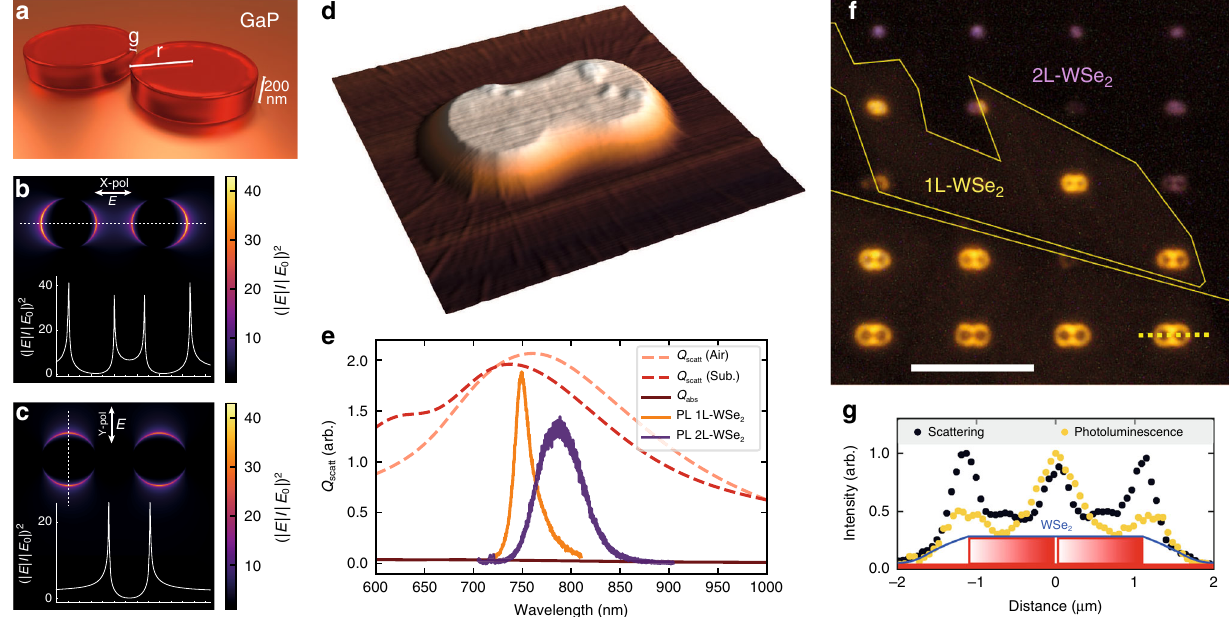
Fig. 1 Coupling of an atomically thin semiconductor to a dielectric nano-antenna. a Schematic view of a GaP dimer nano-antenna with a height h = 200nm, gap jÞ 2 of light at 685nm scattered by a GaP dimer with r = 50nm, h = 200nm, and g = 65nm. width g , and pillar radius r . b , c Calculated relative intensity ðj E j = j E 0 E ( E 0 ) is the electric fi eld amplitude of the light scattered by (normally incident on) the dimer. The polarisation of the incident light is shown with arrows. ðj E j = j E jÞ 2 is calculated at the height of 200nm corresponding to the top surface of the pillars. The inset shows the variation of ðj E j = j E jÞ 2 along the horizontal 0 0 and vertical dotted lines. d Atomic force microscopic (AFM) image of a GaP nano-antenna ( r ¼ 500 nm) covered with a monolayer WSe 2 . e Simulated ) and absorption ( Q ) ef fi ciency integrated over numerical aperture NA = 0.9 for a GaP nano-antenna ( g = 35nm, r = 100nm) illuminated scattering ( Q scatt abs with a plane wave. Pink (red) dashed line Q for light scattered upwards in air (downwards into the substrate). Room temperature PL spectra are shown for scatt 1L-WSe 2 (orange) and 2L-WSe 2 (purple). f Optical microscopic image showing PL from dimer nano-antennas array covered with 1L- and 2L-WSe 2 illuminated with unpolarised white light (see ‘ Methods ’ for details). Scale bar is 10 μ m. The yellow lines show the boundaries between 1L- and 2L-WSe 2 . PL from 1L (2L) sample shows as false yellow (purple) in the image. g Intensity pro fi les extracted from a dark- fi eld (black) and PL (yellow) microscopic images for a dimer with r = 500nm measured along the dashed line in e . The intensity pro fi les are overlaid with the schematic of a